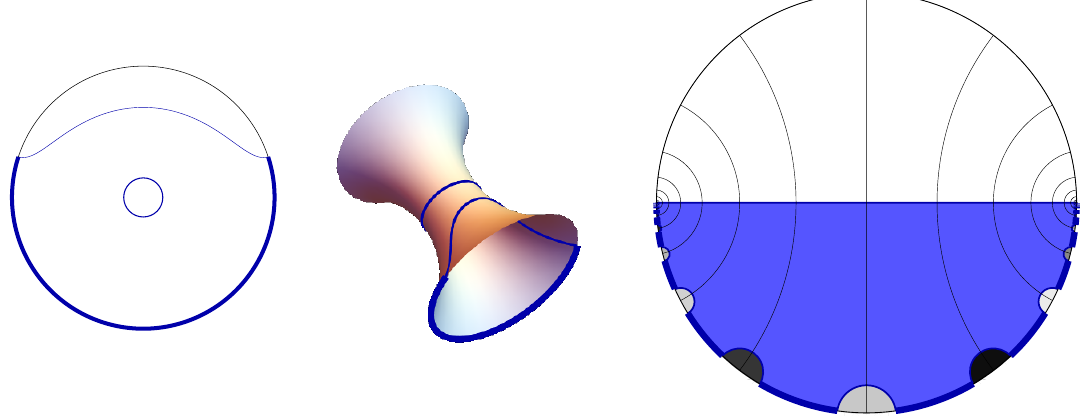
Figure 10 . Left: the one-sided BTZ geometry. There are two types of intervals, whose HRT surfaces either consist of a single geodesic (‘small’ intervals, here non-highlighted) or include the black hole horizon (‘large’ intervals, highlighted). In our proof, we (cid:12)rst purify the state by gluing it with its CPT conjugate (the two-sided BTZ geometry, center panel) and then go to its universal cover (a spatial slice of AdS 3 , right panel). The images of a small interval end up in the disconnected phase (colored with diverse shades of gray); the images of a large interval are in the connected phase, one of whose geodesics is the concatenation of the images of the black hole